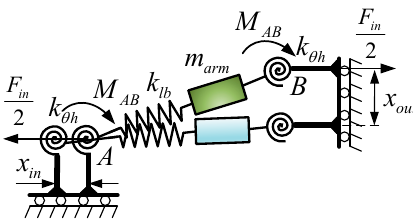
Figure 6. Static model of the single bridge arm.